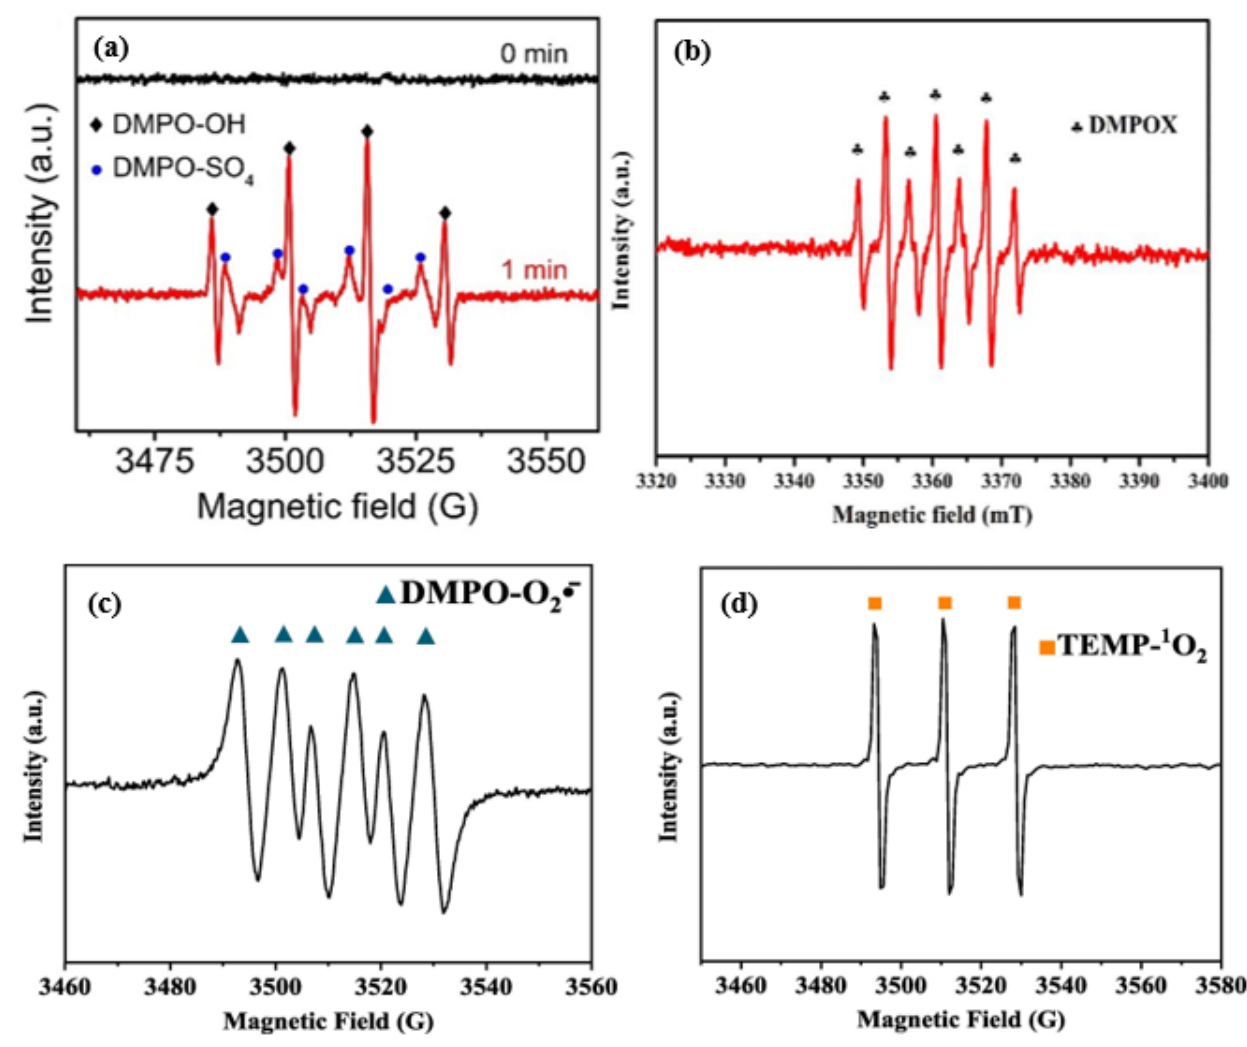
Figure 3. EPR characteristic spectrum of ( a ) DMPO-SO 4 ·− and DMPO- · OH; ( b ) DMPO-X; ( c ) DMPO- O 2 ·− ; and ( d ) TEMP- 1 O 2 [80–82].